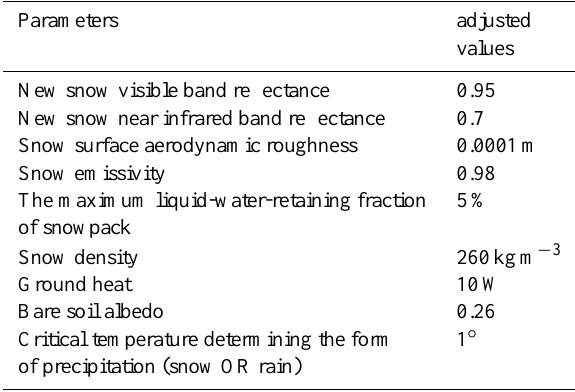
Table 1. Adjusted parameters on the point